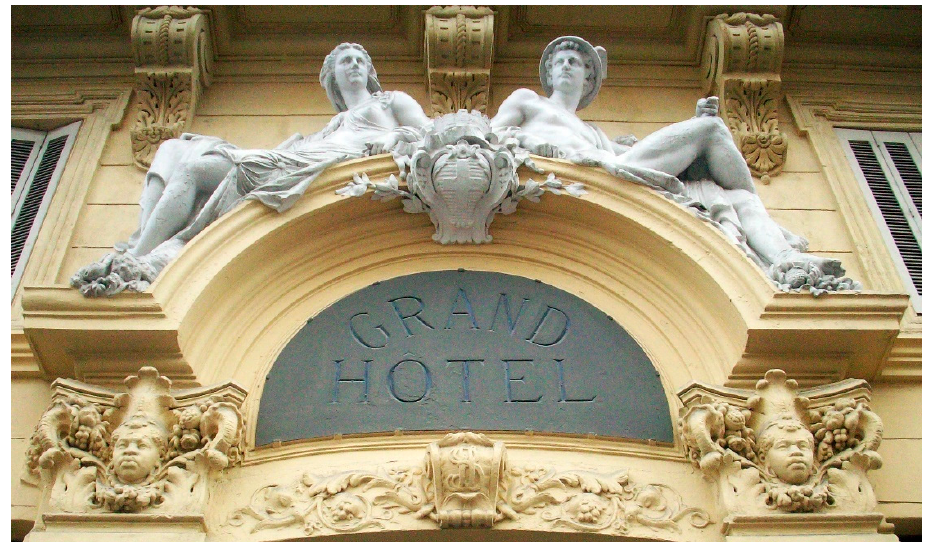
Figure 14. The Grand Hotel de Noailles in Marseille, which was built by Victor Régis in 1862. Photograph courtesy of the Regis family.